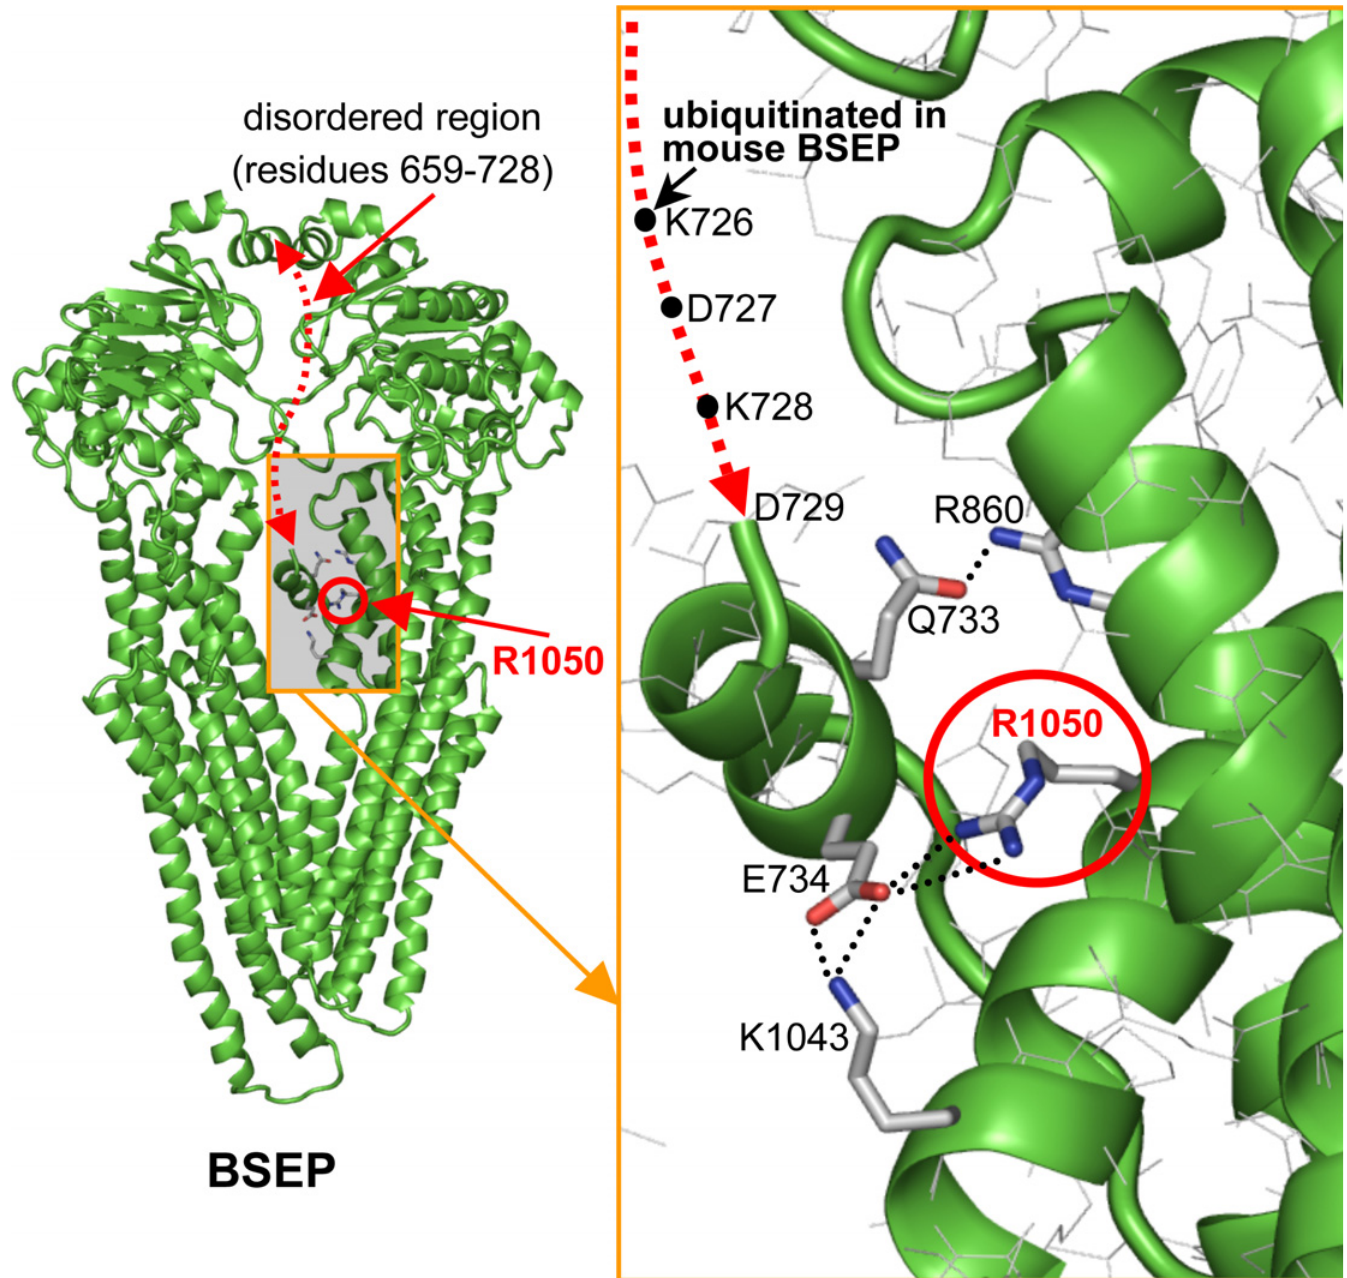
Fig 3. Model of BSEP and detailed view around the site of the R1050C mutation. Shown as sticks are the residues that stabilize, via non-covalent interactions, the short helix contiguous to the 659 – 728 disordered region (red dotted line). Hydrogen bonds and salt-bridges are indicated by black dots between residues. The schematic positions of the three most C-terminal residues of the disordered peptide are indicated. These include Lys 726, the residue found to be ubiquitinated in the mouse